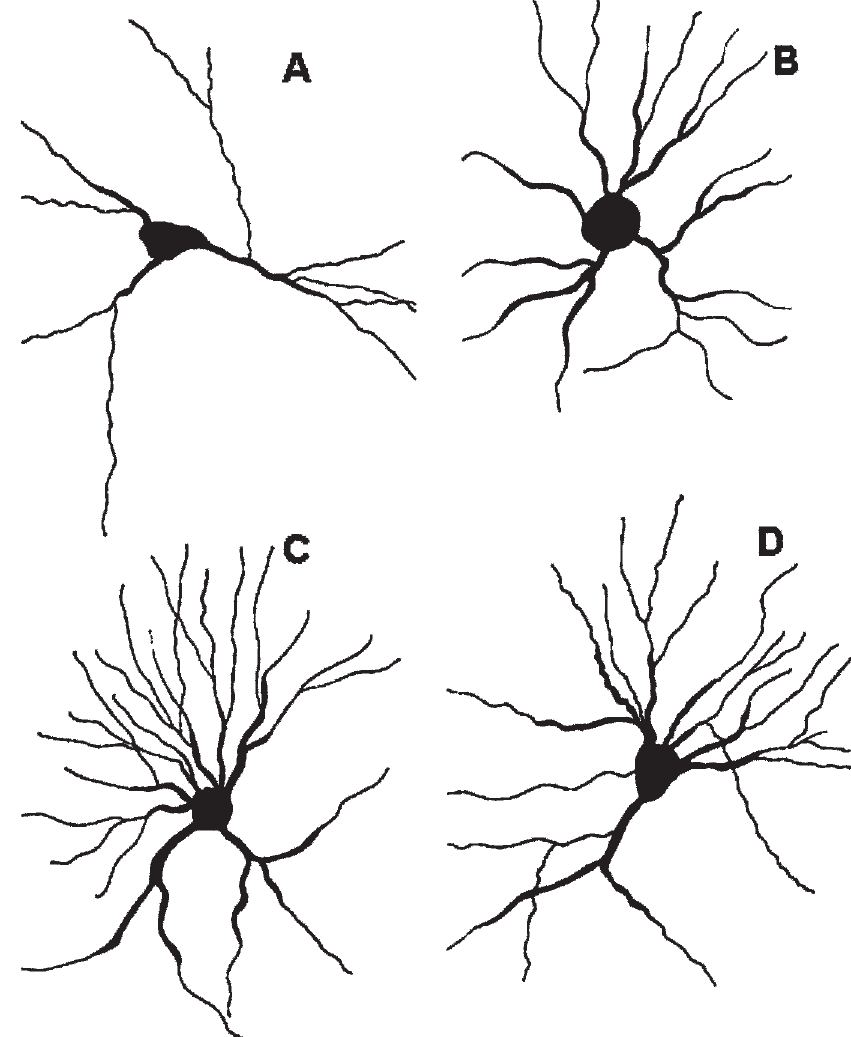
Figure 5 - Camera lucida tracings of basolateral amygdaloid neurons from control rats A) and rats treated with Bacopa monniera for 6 weeks at doses of 20 mg/kg B), 40 mg/kg C) and 80 mg/kg D).